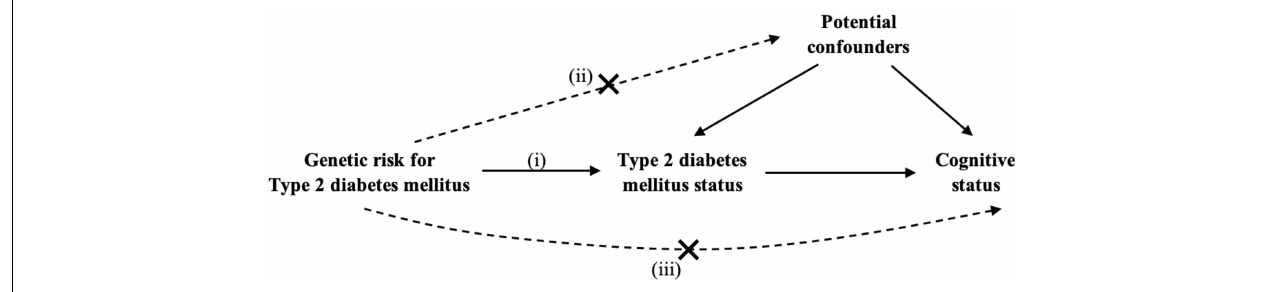
FIGURE 1 | Mendelian randomization analyses structure and subsets of study population, Health and Retirement Study, Wave 2010 ( n = 10,322). CIND, cognitive impairment non-dementia. a Mendelian randomization assumptions: (i) the genetic variant must be associated with the exposure, (ii) the genetic variant must not be associated with any confounder of the exposure-outcome association and (iii) the genetic variant must be associated with the outcome only via the exposure. b Subsets used in multivariable logistic regression and Mendelian randomization analyses: participants with (A) non-missing values in Type 2 diabetes mellitus status + CIND or normal cognitive status; (B) non-missing values in Type 2 diabetes mellitus status + dementia or normal cognitive